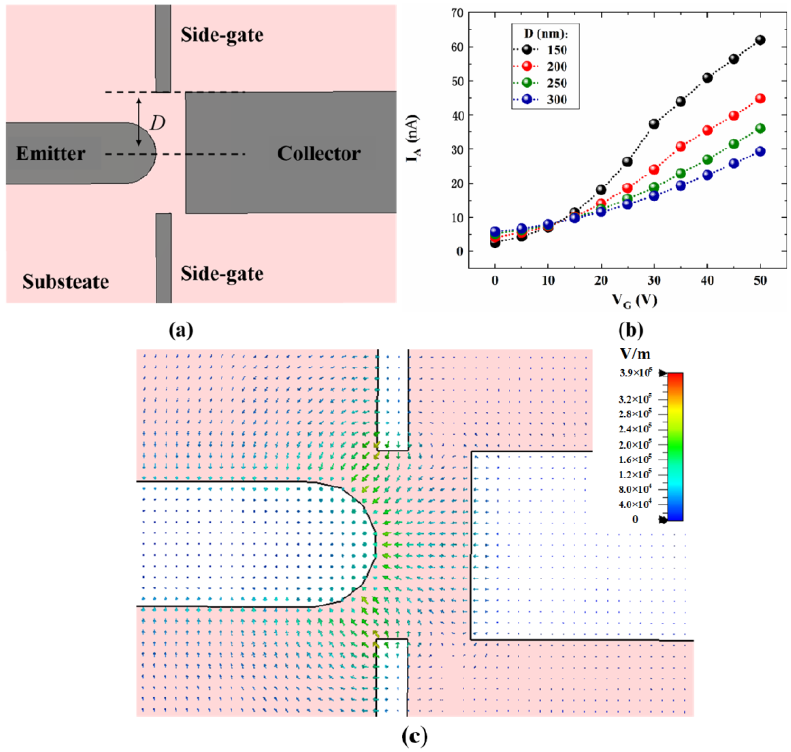
Figure 8. ( a ) top view of structural model of side-gate devices, ( b ) I A versus V G with different distance D between gate to the center line with V A of 20 V, ( c ). electric field of side-gate devices.